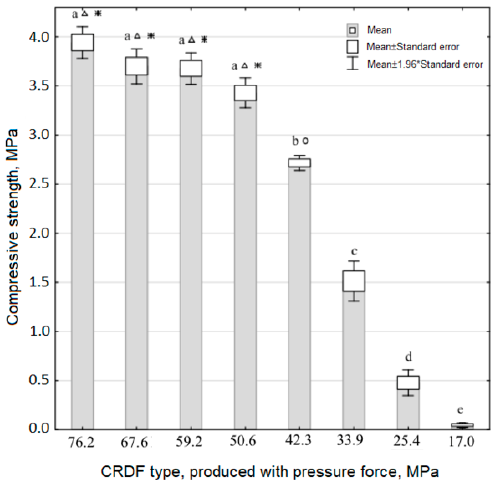
Figure 2. Compression strength of carbonized refuse-derived fuel (CRDF) pellets as a function of applied pressure used for pellet production—letter designations ‘a–e’ denote statistically significant ( p < 0.05) differences between samples inside combination I, geometric markings indicate statistically significant ( p < 0.05) differences between combinations I, II and III.